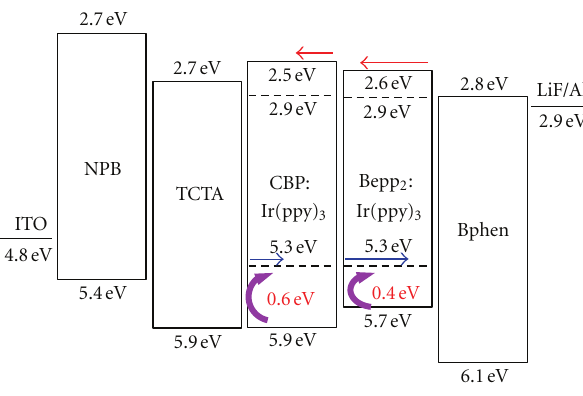
Figure 13: Energy band diagram of CBP:Ir(ppy) 3 and Bepp 2 : Ir(ppy) 3 based green